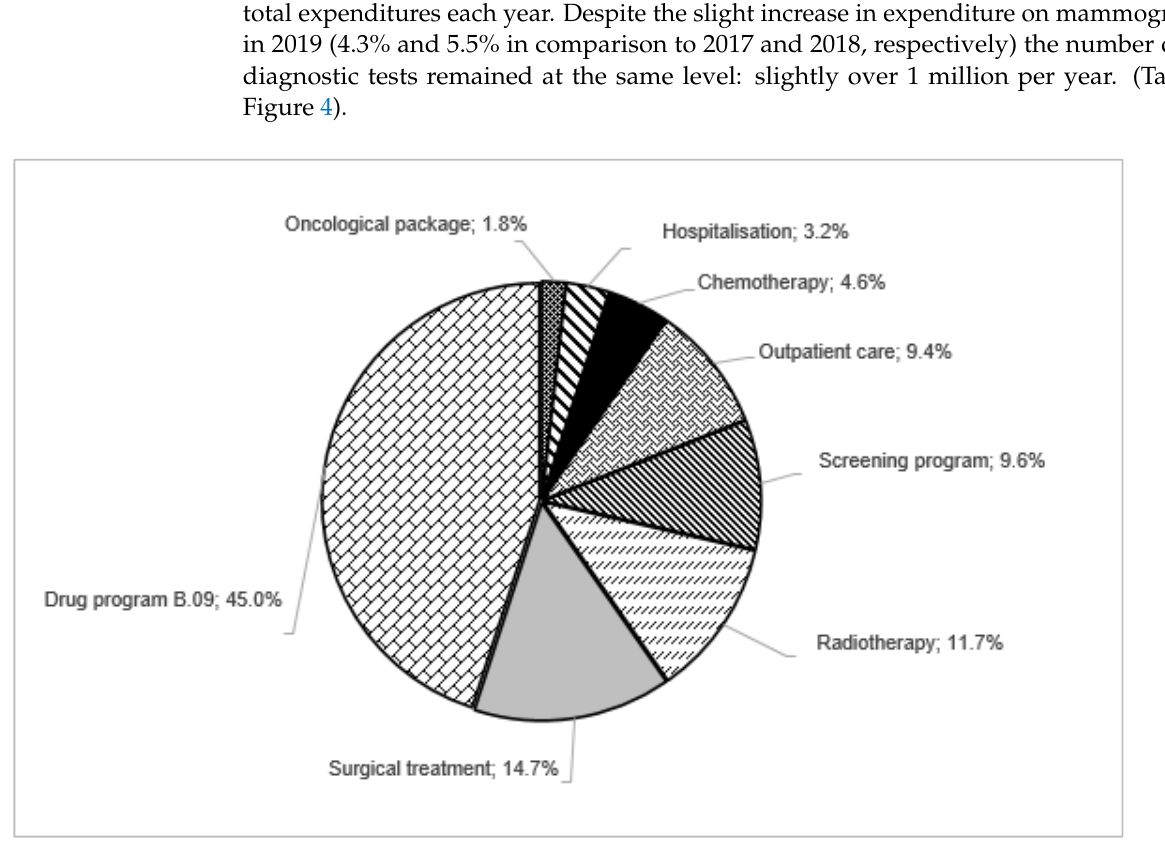
Figure 4. Distribution of direct costs components (2019).